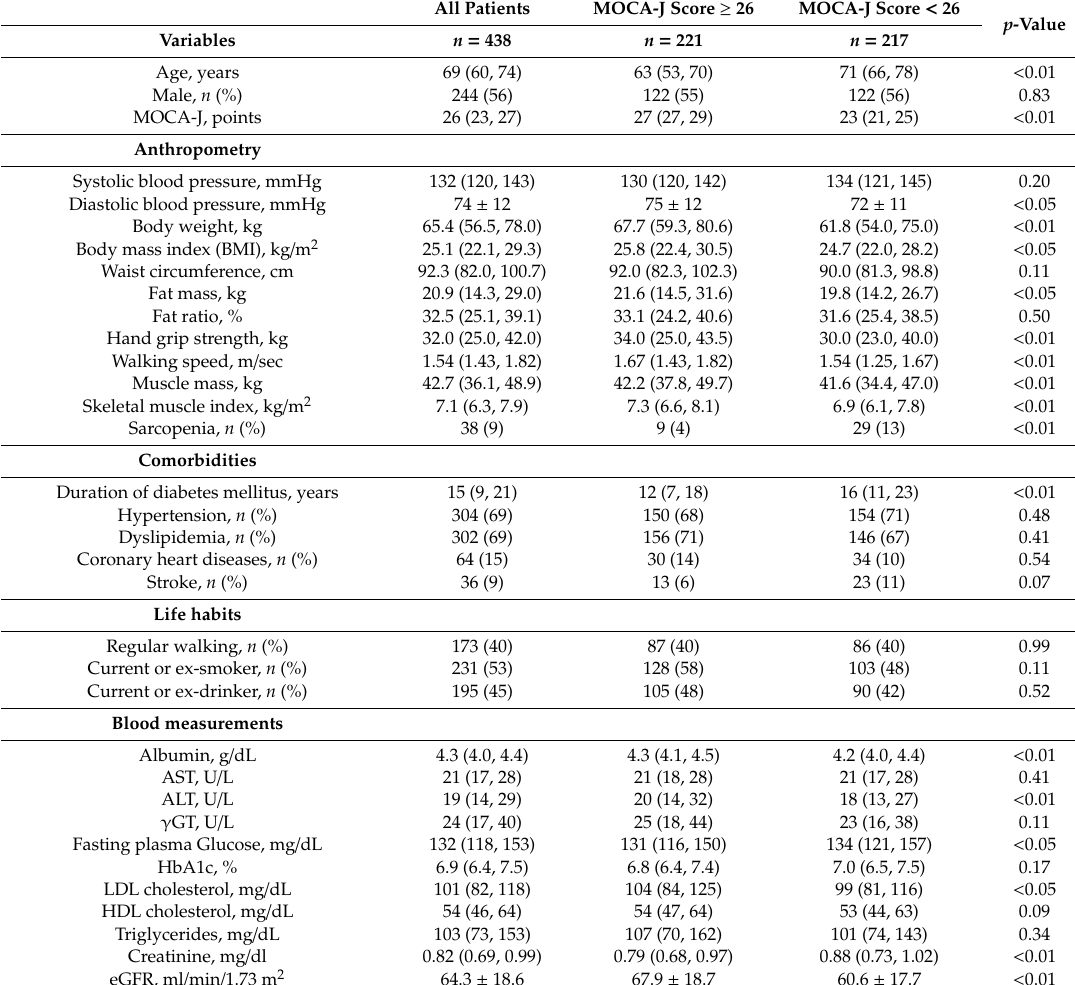
Table 1. Baseline characteristics of studied patients with type 2 diabetes mellitus. All Patients MOCA-J Score ≥ 26 MOCA-J Score <